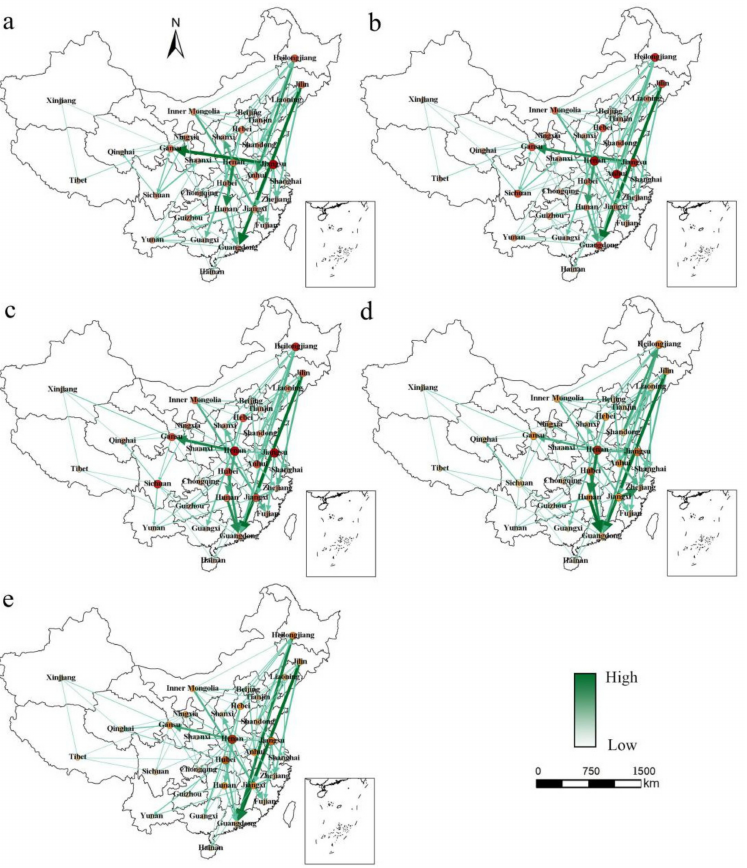
Figure 1. Virtual water trade network (VWTN) of China’s major crops. ( a – e ) represent virtual water trade networks in 2000, 2005, 2010, 2015, and 2017, respectively. The thicker the line, the larger the content of VWT.